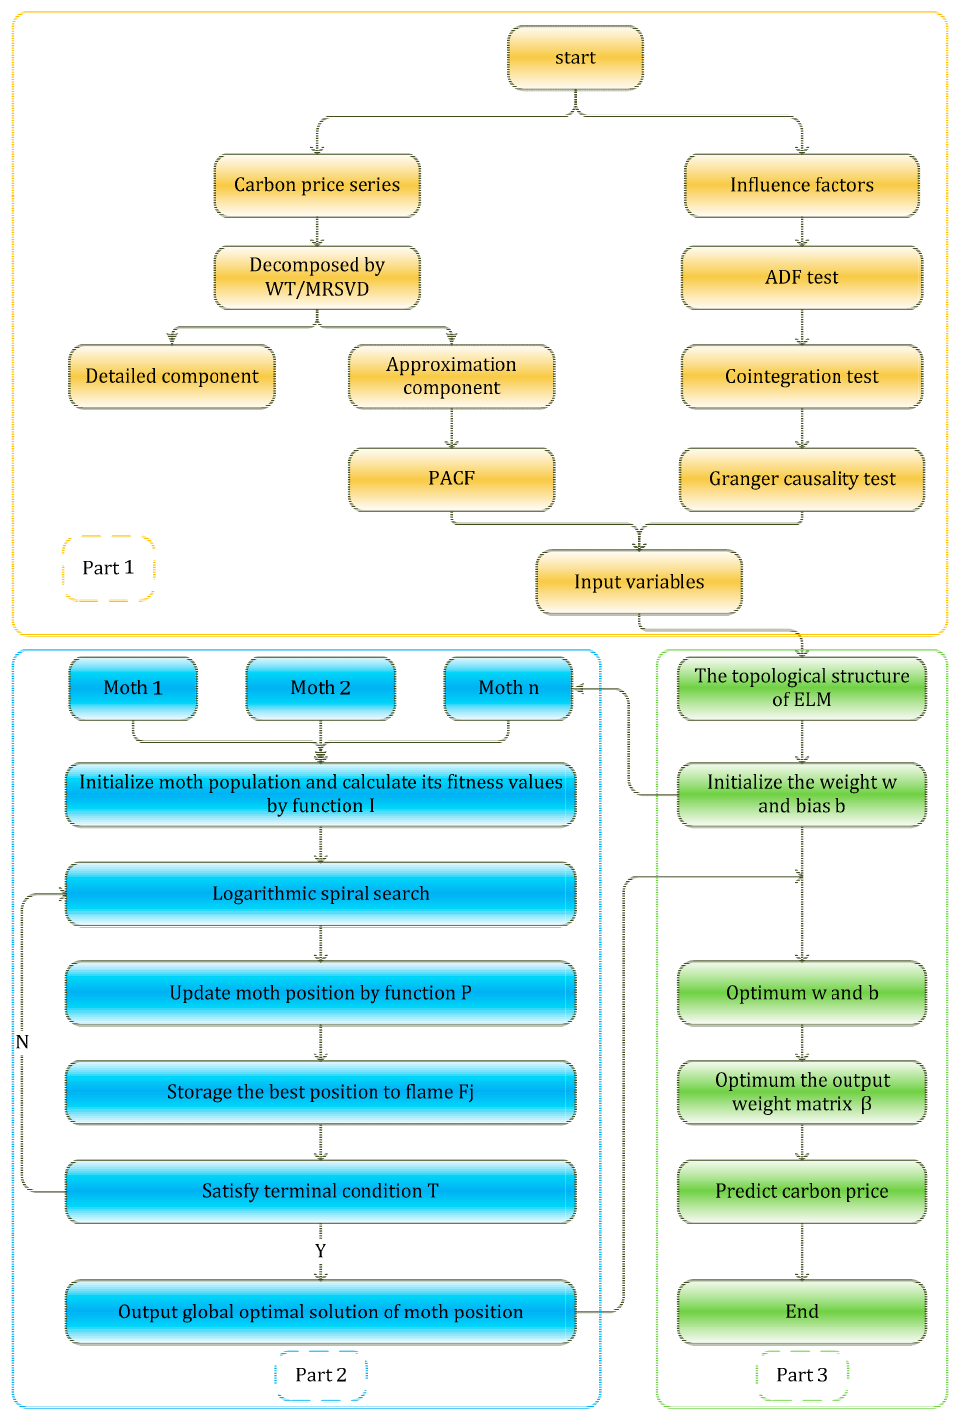
Figure 2. The flowchart of the carbon price forecasting model